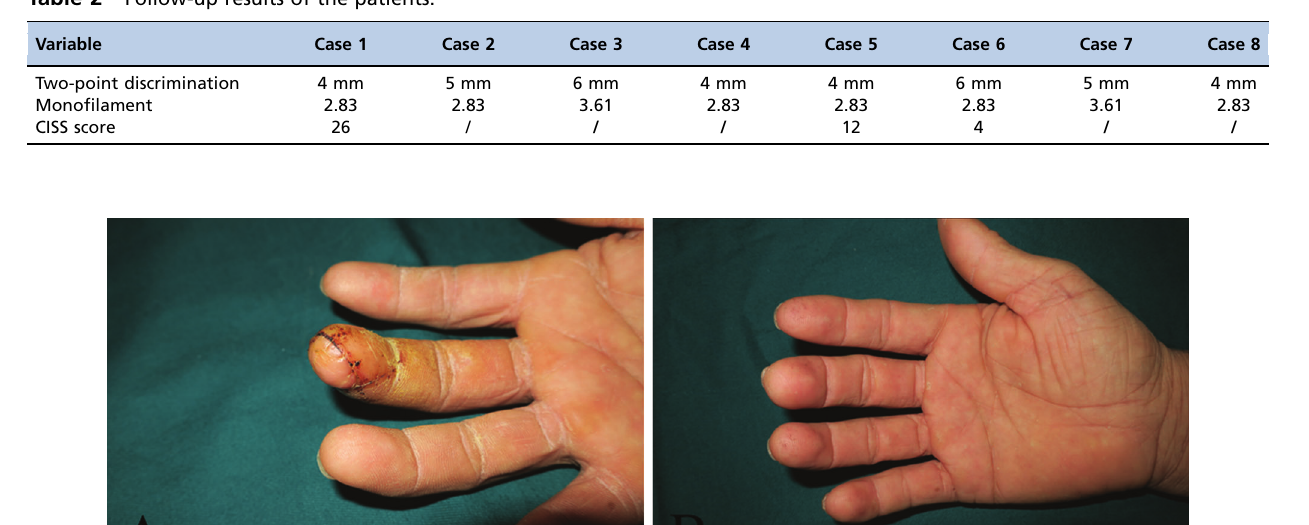
Table 2 - Follow-up results of the patients.